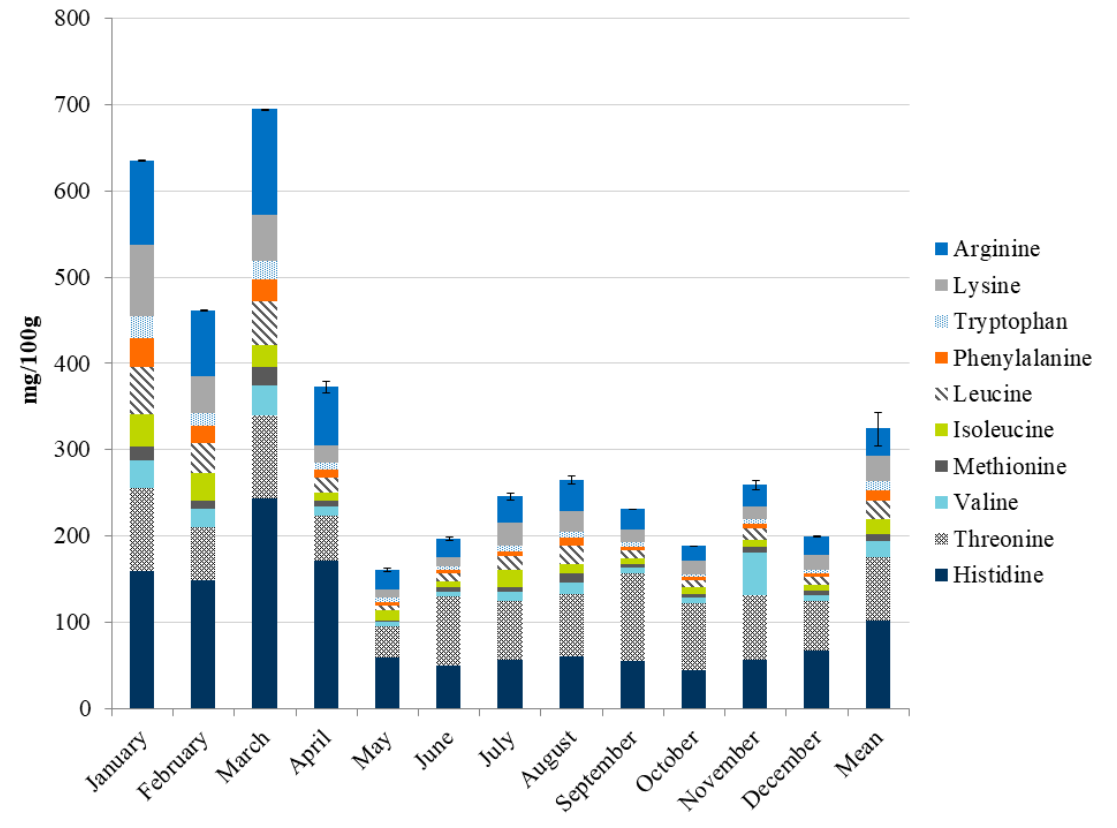
Figure 1. The sum of essential free AA, mg/100 g of arginine, histidine, isoleucine, leucine, lysine, methionine, phenylalanine, threonine, tryptophan, and valine) in sardine fillets over a one-year period.